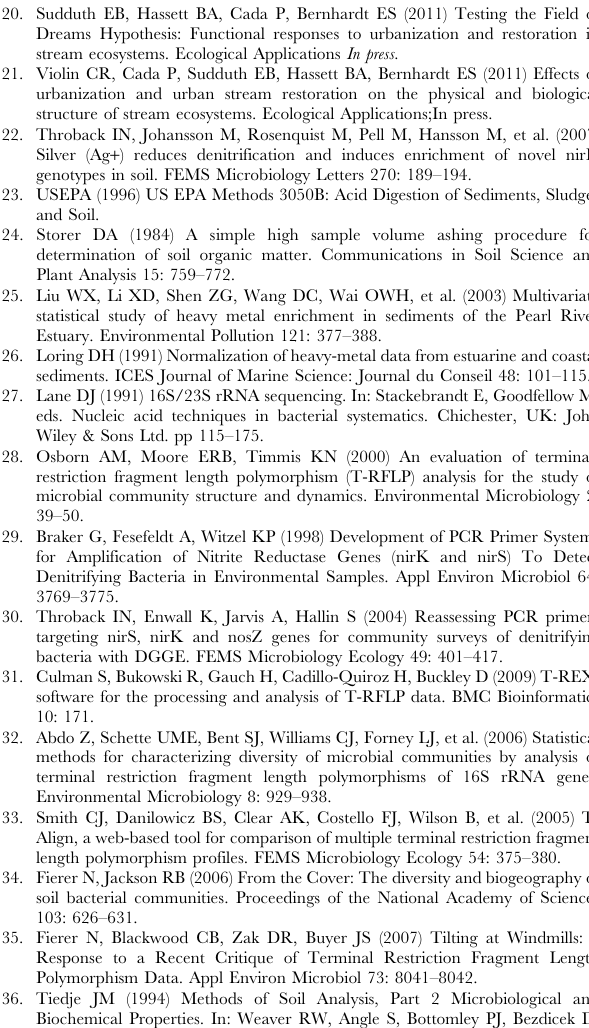
Table S1 Heavy metals concentrations in stream sediments. Table S2 Stream sediment mean water and organic carbon content. Table S3 Correlations (Pearson’s r ) between watershed metrics and measured stream characteristics across all sites and dates.